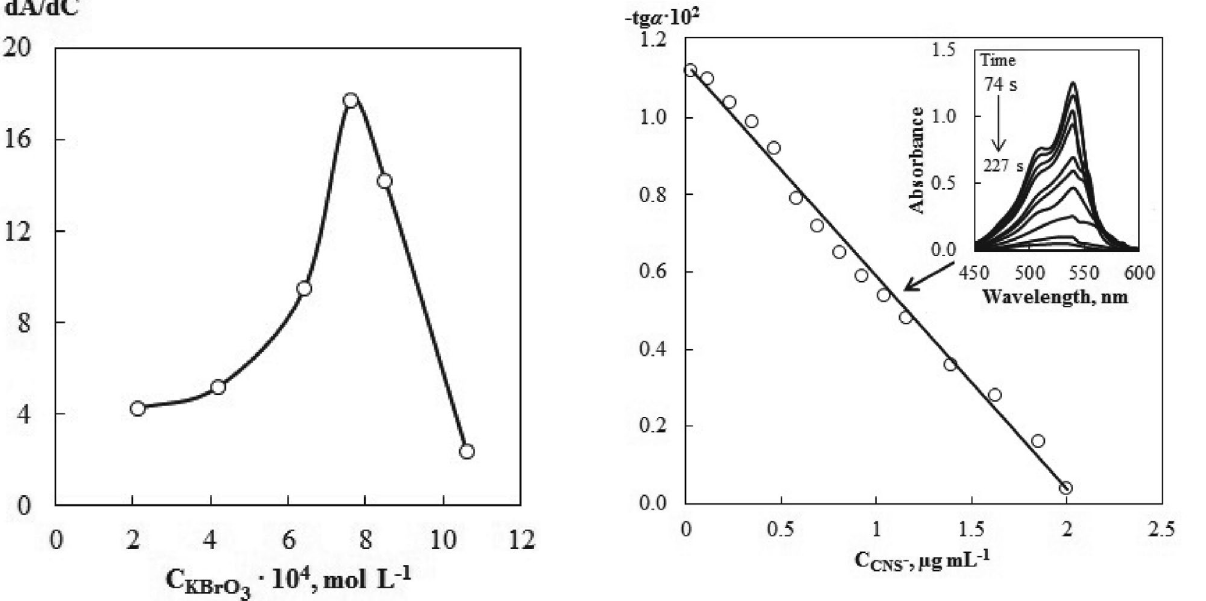
Fig. 3 .The differential dependence of absorbance on bromate con- centration, C astrafloxine FF = 1 × 10 –5 mol L –1 ; pH 1.5; C CNS – = 2 × 10 –5 mol L –1 ; l = 1 cm.